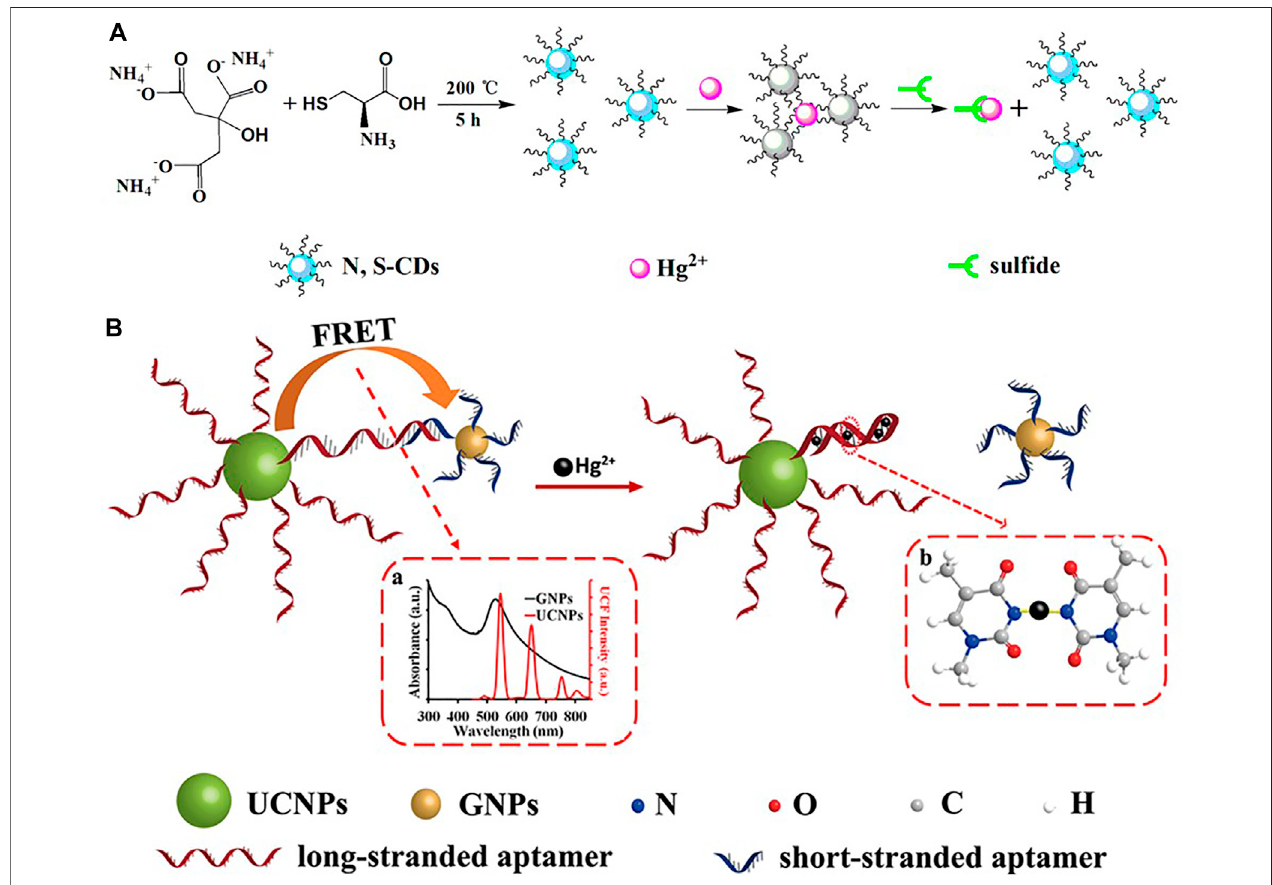
FIGURE7 | (A) Schematic Illustrationof the Strategy for Hg 2+ Ion and Sul fi de Detection (Wu and Tong, 2019); (B) Schematic description of the UCNPs-aptamers- GNPs FRET sensor for Hg 2+ (Liu et al., 2018).